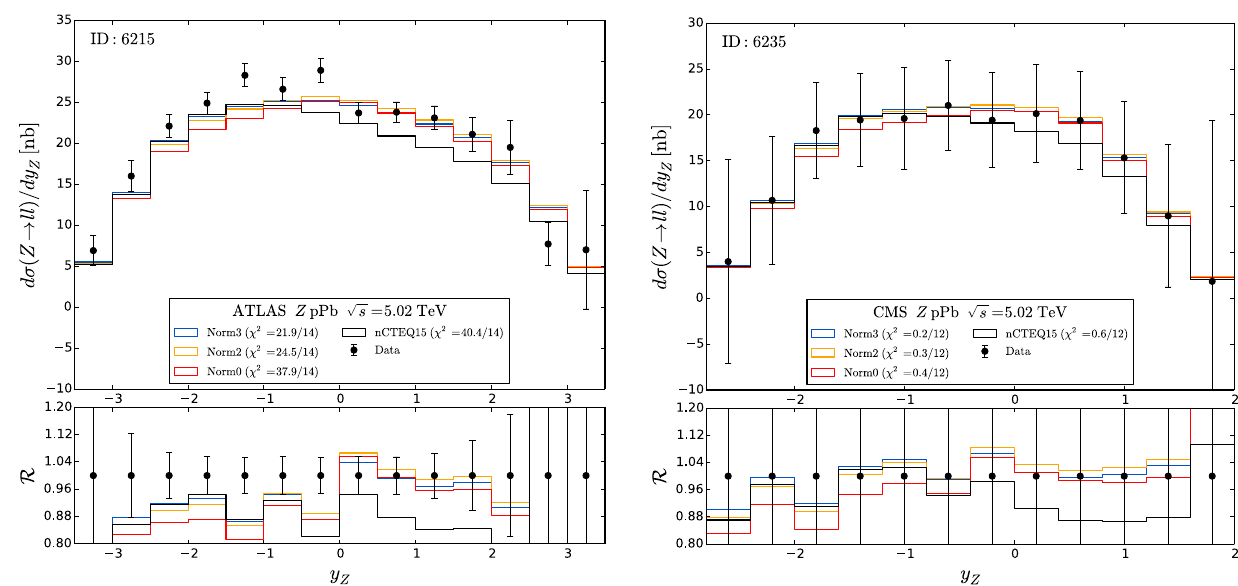
Fig. 4 Comparison of data with theory for ATLAS and CMS Z production. The normalization shifts are applied to the theory so we can compare all the results on a single plot; the data is unaltered. For reference, ATLAS Run I { Z } = { 6215 } and CMS Run I { Z } = { 6235 }